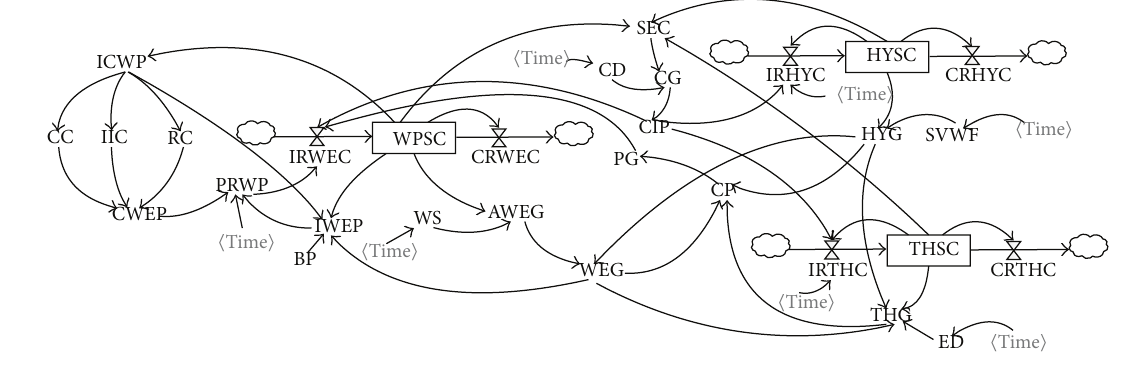
Figure 2: Stock and flow diagram. Table 3: Policy combinations.